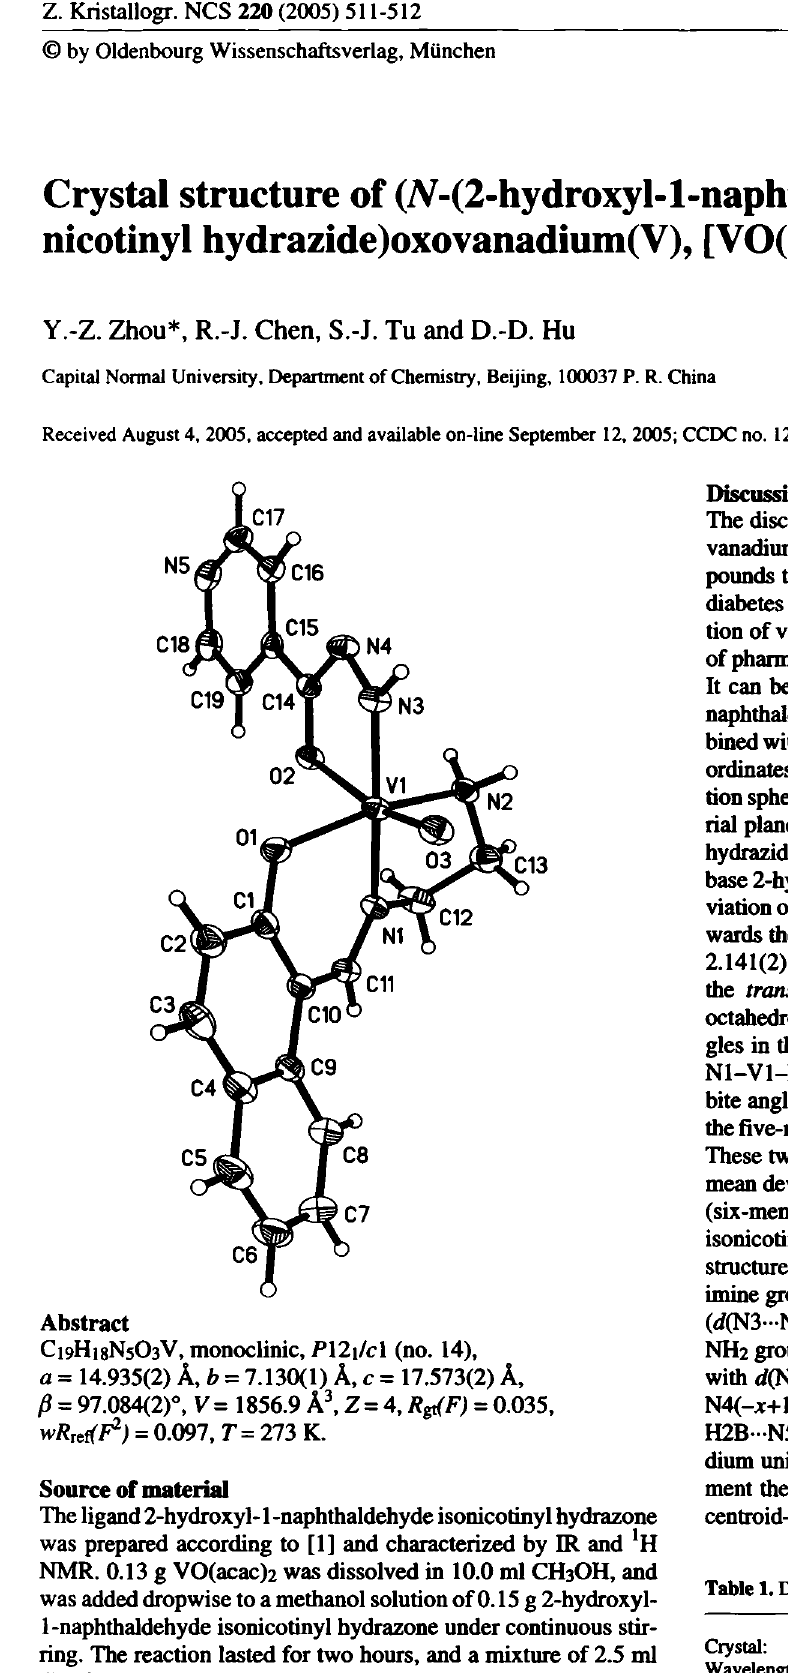
Table 1. Data collection and